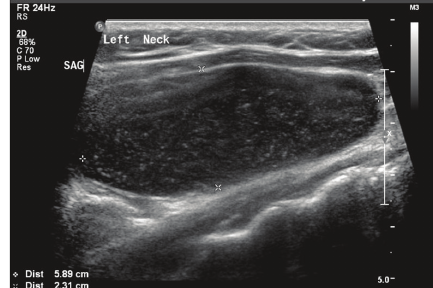
Figure 1: Ultrasound-sagittal view showing the large cystic lesion.